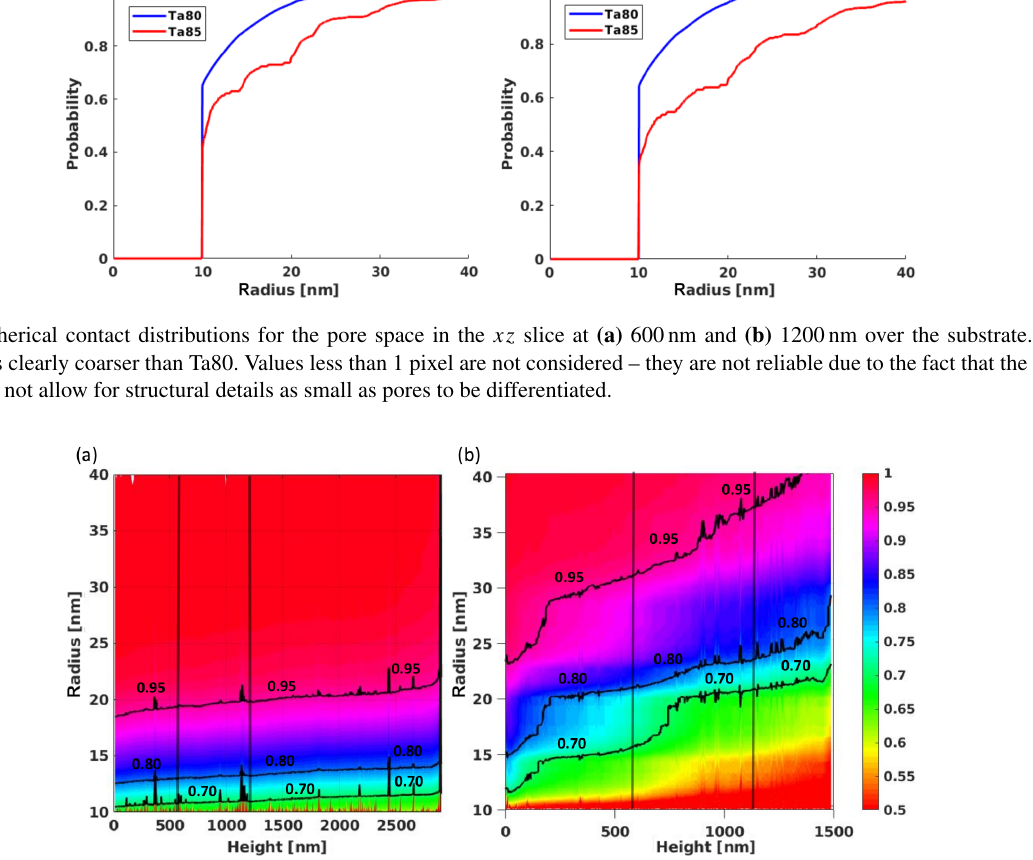
Figure 12. Spherical contact distributions in xz slices as functions of the height over the substrate. Values of the spherical contact distribu- tions given by the color map. The 70th, 80th, and 95th percentiles are delineated. Vertical lines at 600 and 1200nm indicate the location of the curves represented in Fig. 11. Panel (a) represents Ta80, and panel (b) represents Ta85. For Ta80, the spherical contact distributions do not change significantly with height. The probability of reaching the solid within 20nm of a random point in the pore space is nearly 1. For sample Ta85, this distance is considerably larger than in Ta80. Moreover, it clearly increases with height, which means that the comparably coarse pore structure becomes even coarser from bottom to